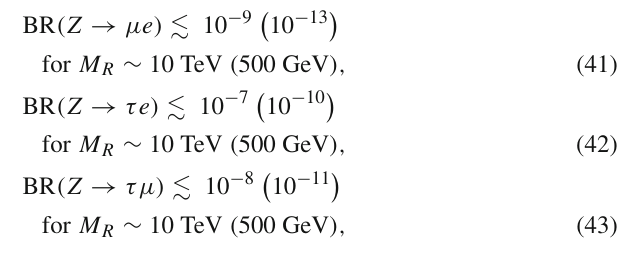
and f = 0 . 1 , 0 . 5 , 1 , 2. The chosen example GF is explained in the text. Shadowed areas are disallowed by global fit results (purple) or for giving non-perturbative Yukawa couplings